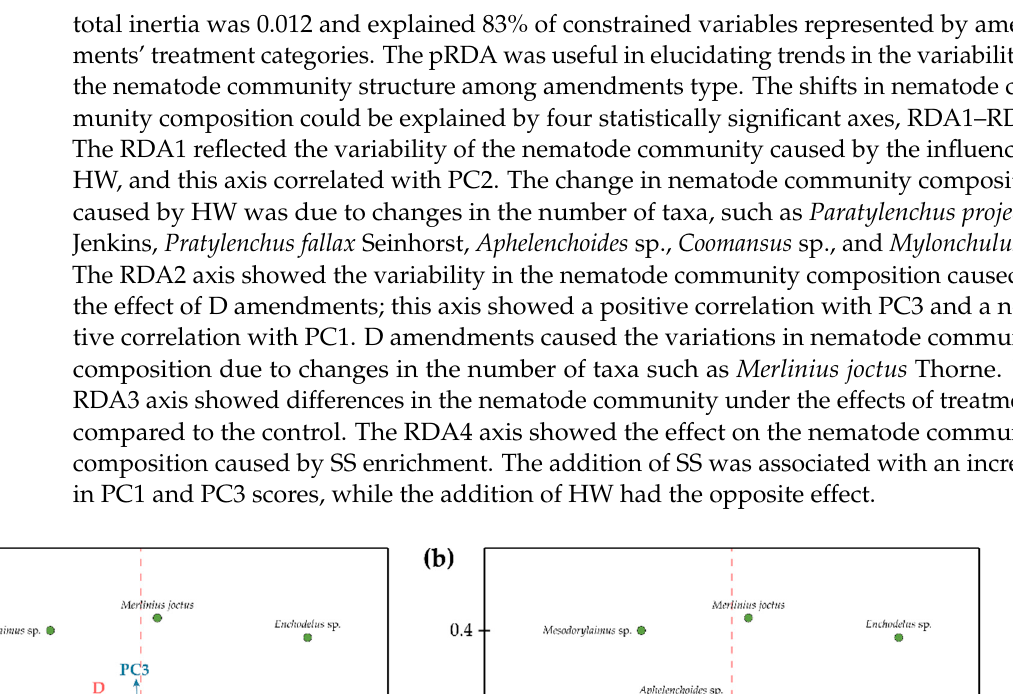
Figure 2. Nematode faunal analysis indicating the food web status (A–D) in different amendments type: BD1, BD2, D, SS, and HW.